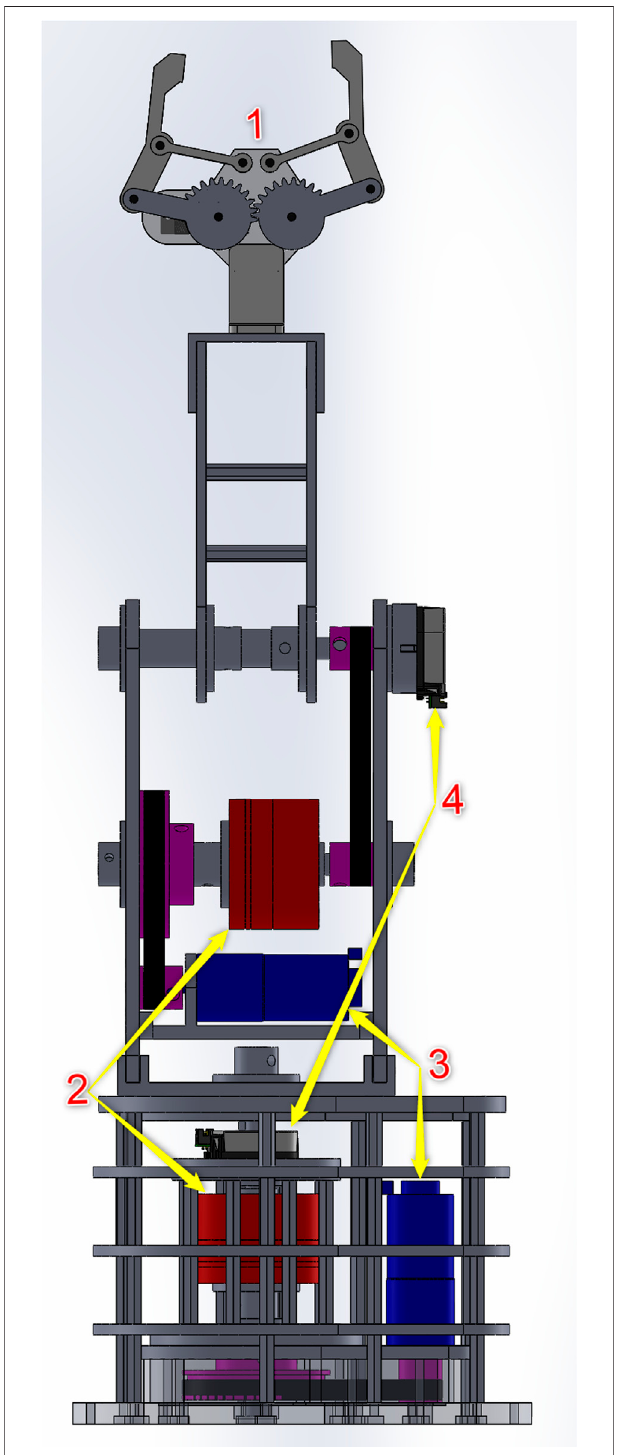
FIGURE 7 | Mechanical design of the 2-DOF robot arm with elastic joints: (1) Gripper, (2) elastic joints, (3) GA25 DC motors, (4) AMT20 encoders.